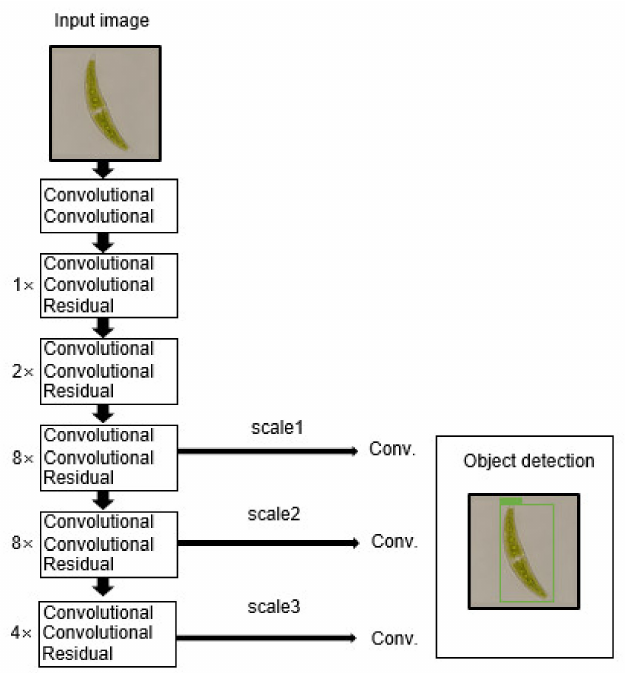
Figure 1. A schematic of YOLO v3